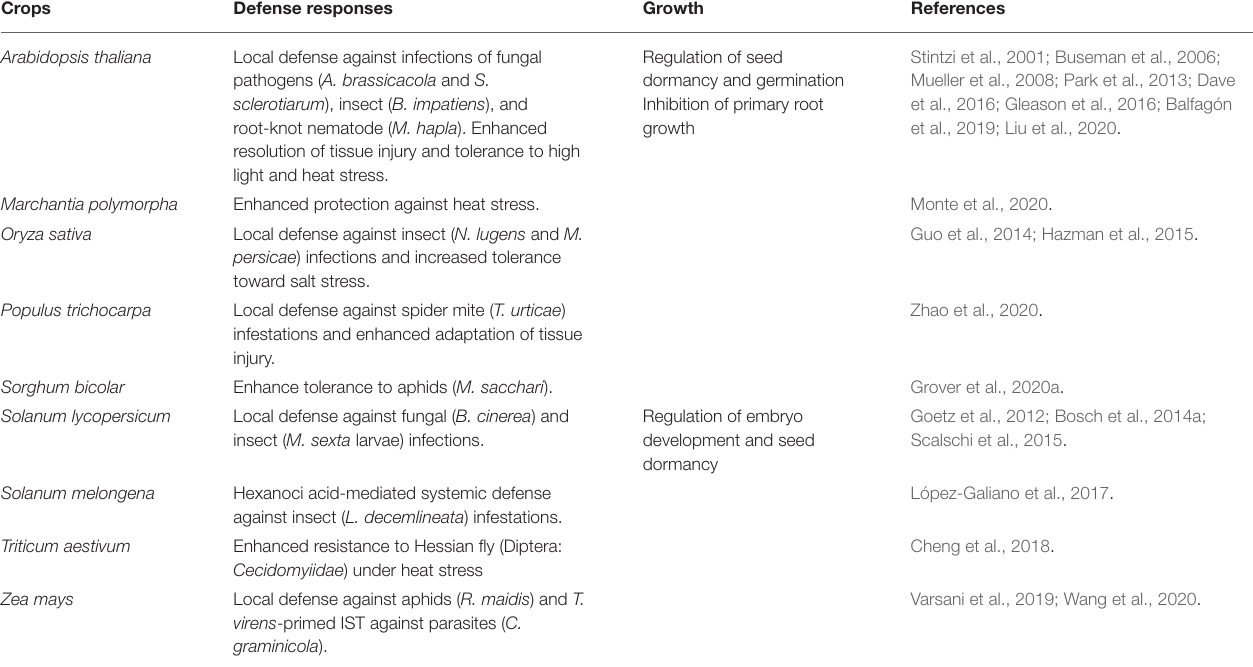
TABLE 1 | Biophysiological activities and functions of OPDA across diverse plant